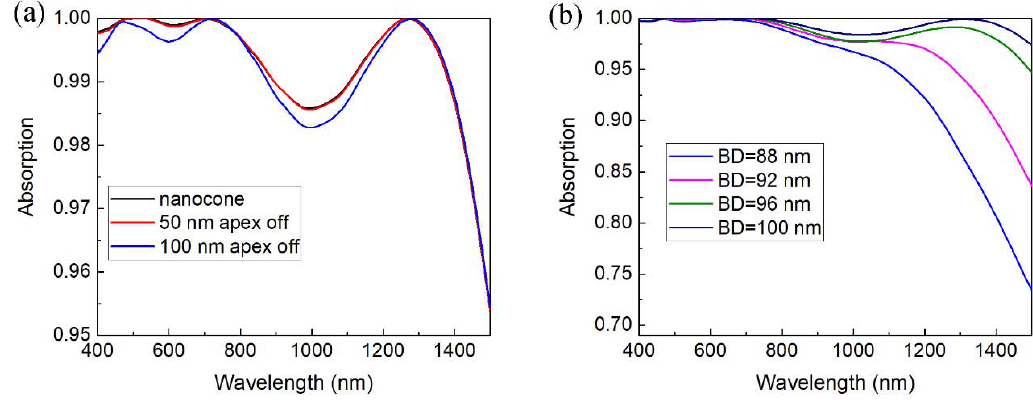
Figure 5. ( a )Absorption spectra with different height apex-offs when BD = p = 100 nm, t = 25 nm and h = 330 nm; ( b ) absorption spectra with respect to different BD while the other parameters are fixed at p = 100 nm, t = 25 nm and h = 330 nm.